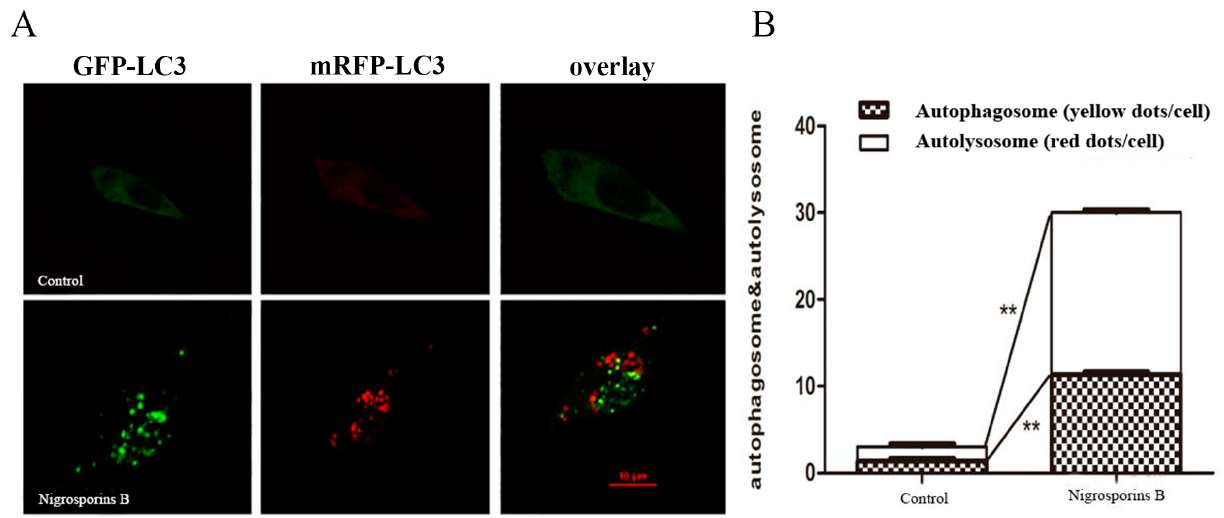
Figure 7. Nigrosporins B induced autophagic flux in Ca Ski cells. Ca Ski cells transfected with mRFP-GFP-LC3 were treated with Nigrosporins B for 18 h. ( A ) Cells transfected with mRFP-GFP-LC3 adenovirus were recorded by a confocal fluorescence microscopy; ( B ) The analysis of red dots and yellow dots in Ca Ski cells (* p < 0.05, ** p < 0.01).